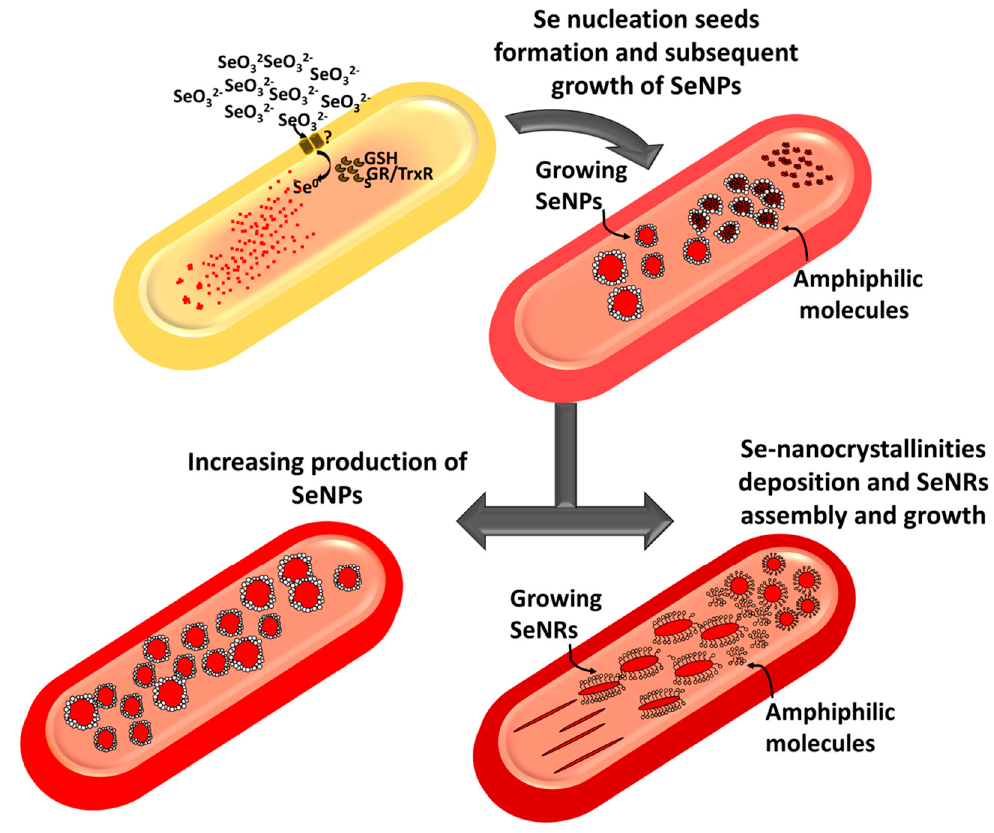
Figure 7. Fast SeO 32 − uptake is followed by its rapid bioconversion within MPV1 cells, causing a build-up of Se 0 atoms in the intracellular environment. Consequently, Se atoms eventually aggregate with each other, and once the solubility threshold concentration is reached, they form intracellular nucleation seeds. This event is followed by the generation of a high amount of intracellular SeNPs, which can be mediated by amphiphilic biomolecules present within the cells that can also provide thermodynamic stability to the forming NSs. SeNRs production is instead favored by the exposure of MPV1 to high concentrations of SeO 32 − as well as its growth-eliciting specific metabolisms, most likely due to the co-production of a high amount of amphiphilic biomolecules as stress response that can act as surfactants, providing a template for the growth of Se nucleation seeds along one axis.